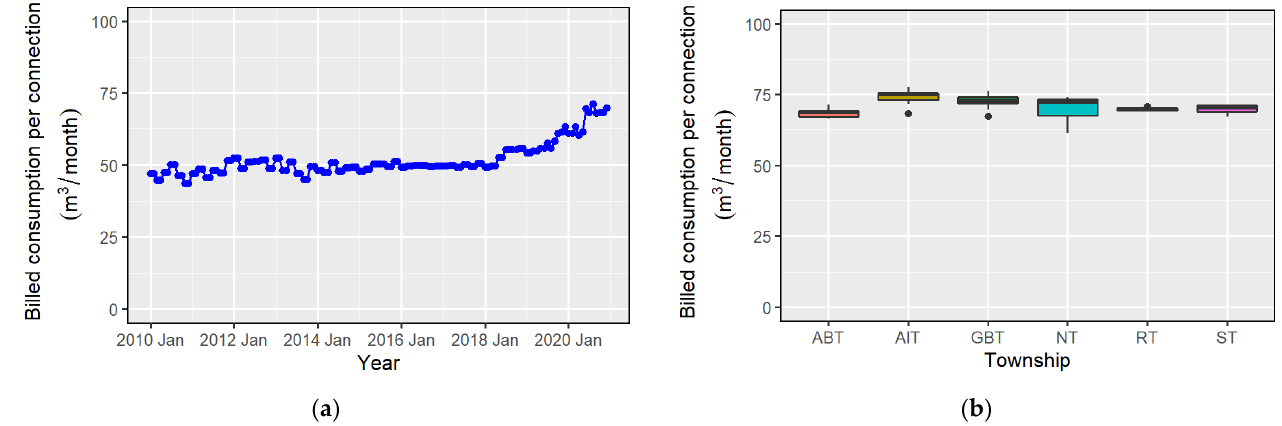
Figure 3. Billed water consumption per connection: ( a ) time-series in Tajpura, and ( b ) for the six townships in 2020. Note: the dot points in the box-plot indicate outliers.